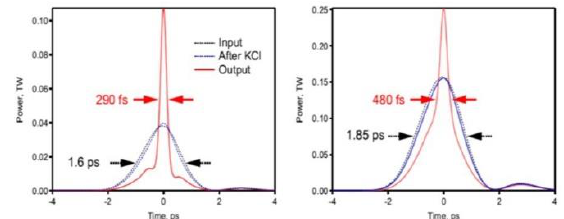
Fig. 4. Results of numerical modelling of the pulse compression in the KCl+BaF 2 configuration at the conditions corresponding to the optimum compression; left – input and output temporal profiles integrated over the 5 mm diameter central portion of a laser beam seen by the AC crystal; right – the same but integrated over the entire